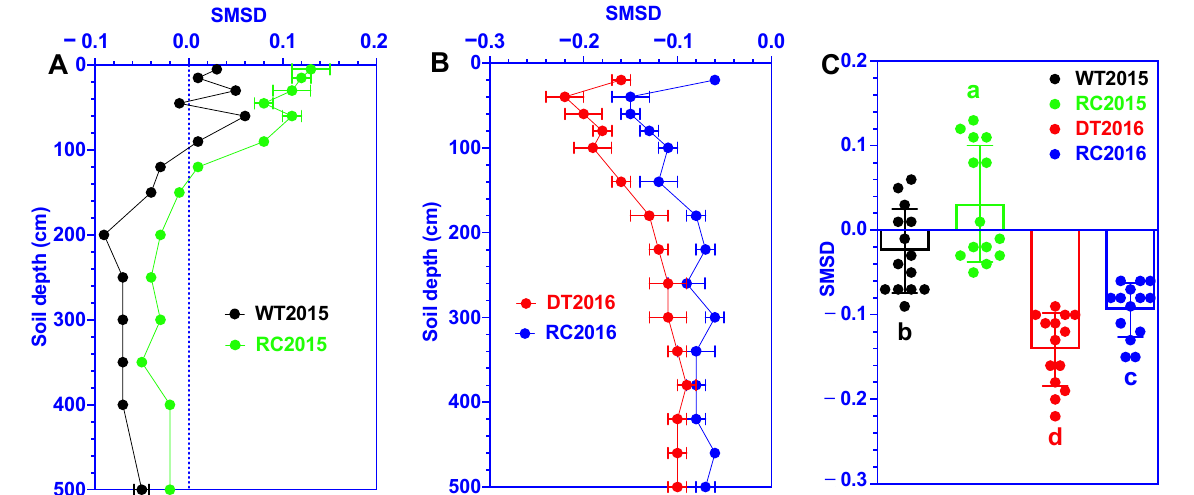
Figure 3. Vertical distribution (0–5 m, A , B ) and content ( C ) of soil moisture storage deficit (SMSD) in a wet year of higher-than-average rainfall (2015, A ) and a dry year of lower-than-average rainfall (2016, B) in Robinia pseudoacacia forest stands of different treatments. Negative and positive values represent, respectively, a negative and positive soil moisture deficit relative to the control (abandoned cropland). Different letters indicate a statistically significant difference at p < 0.05 between treatments. Error bars represent ± 1 SD. WT2015 is wet year of 2015 without in situ rainwater collection and infiltration system; RC2015 is wet year of 2015 with in situ rainwater collection and infiltration system; DT2016 is dry year of 2016 without in situ rainwater collection and infiltration system and RC2016 is wet year of 2016 with in situ rainwater collection and infiltration system.